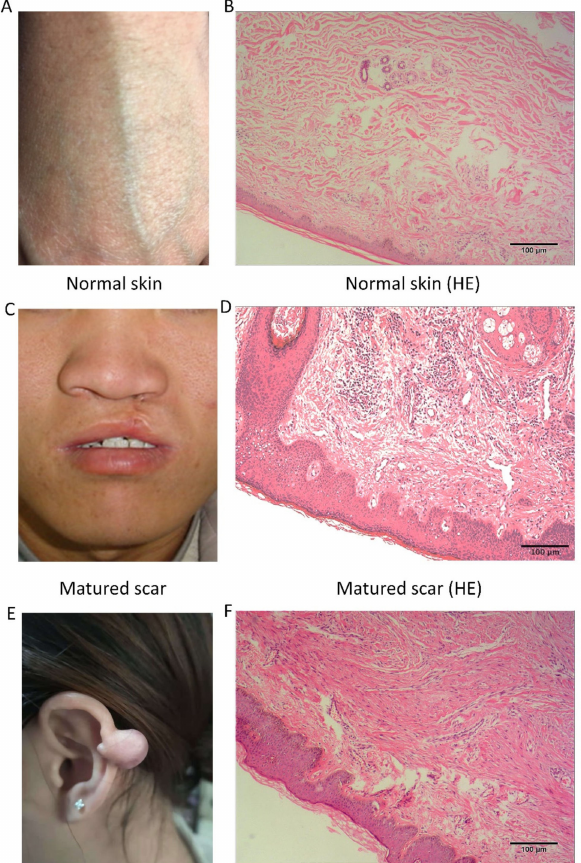
Figure 2. Gross and hematoxylin and eosin (H&E) staining image of normal skin, matured scar and keloid. ( A ) Normal skin. ( B ) H&E staining of normal skin. ( C ) Matured scar. ( D ) H&E staining of matured scar. ( E ) Keloid. ( F ) H&E staining of